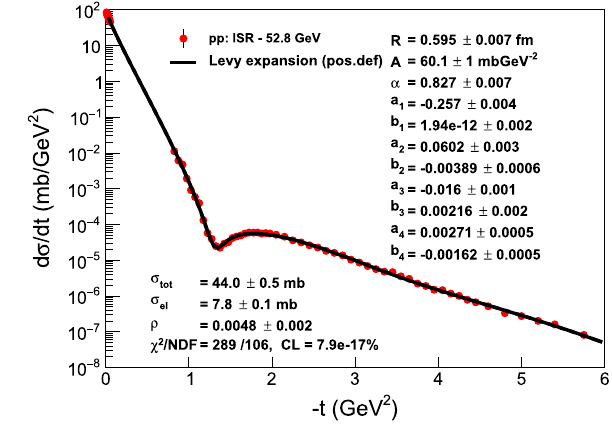
Fig. 22 Fourth-order Lévy expansion fits of the differential cross- section data from Ref. [45] on pp elastic scattering at GeV